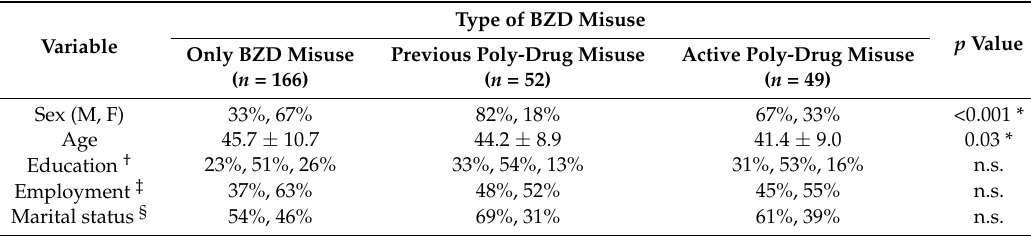
Table 1. Demographic characteristics of the patients according to the type of high-dose benzodiazepines (BZD) and poly-drug misuse.